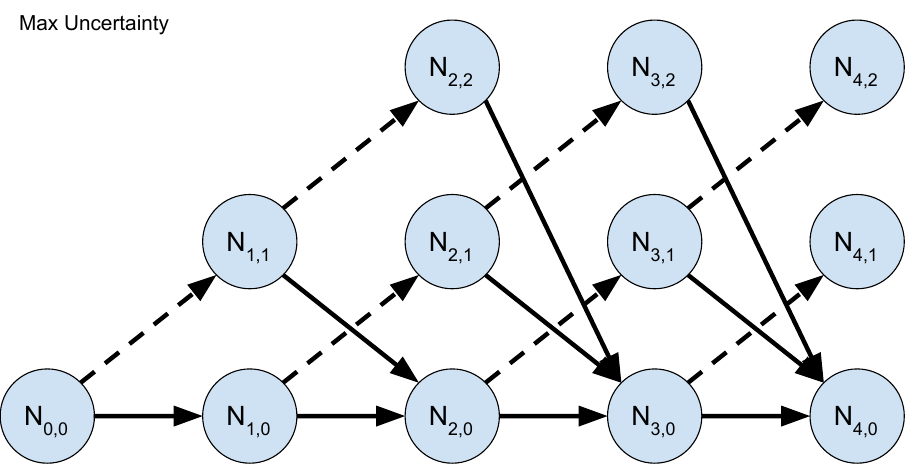
Figure 1. Communication planning graph. The node N n represents the n th node in G . Each node holds the value of σ of a simulation state. The dotted edges represent forward simulation without communication. The solid edges represent forward simulation with